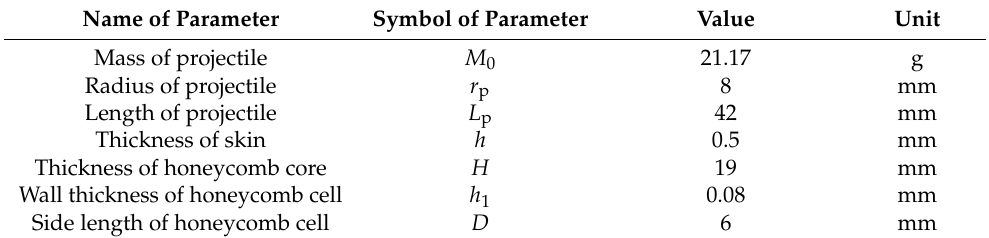
Table 7. Geometry parameters of the projectiles and honeycomb sandwich panel.